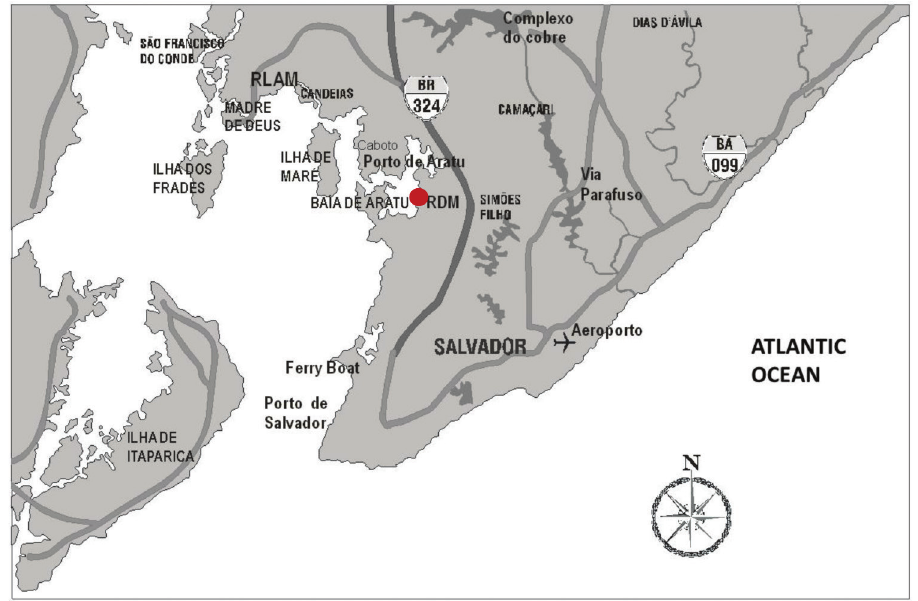
Fig. 1 - Map of Baía de Todos os Santos bay, showing the sampling site (BNA) of this